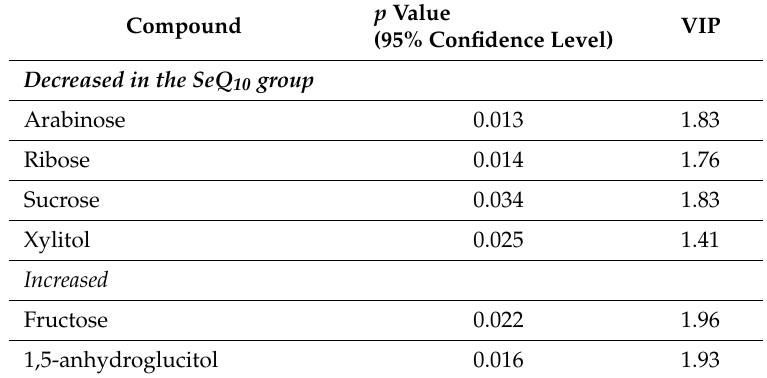
Table 4. Compounds that were found significant according to t -test in at least one batch when SeQ 10 and controls for men at 18 months were compared, with the corresponding p -value and VIP value from this batch.